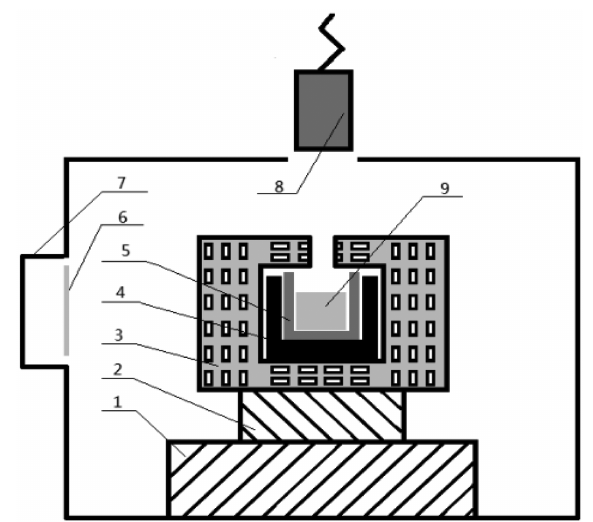
Figure 2: The cavity of high temperature microwave furnace (1-Rotating stage, 2-Loading ring, 3-Alumina insulating sheath, 4-SiC slice, 5-Corundum crucible, 6-Quartz glass, 7-microwave generator, 8-Infrared pyrometer,